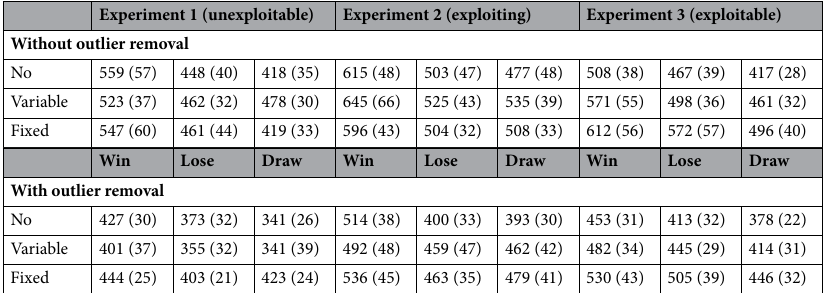
Experiment 1 (unexploitable) Experiment 2 (exploiting) Experiment 3